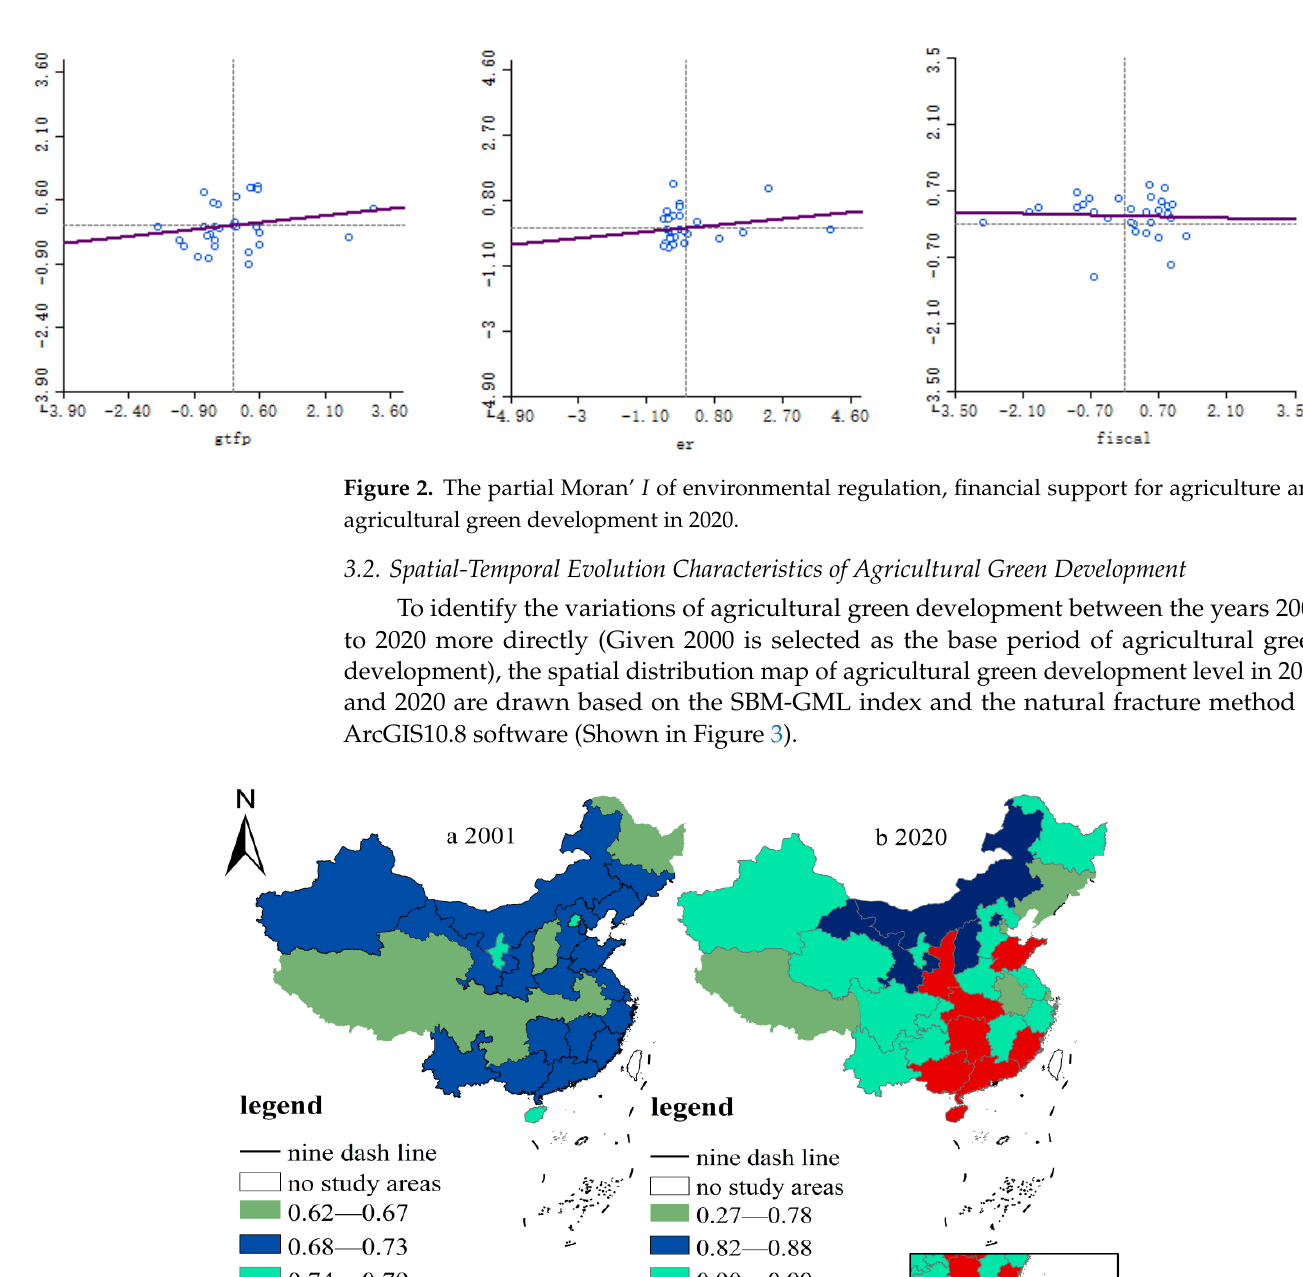
Table 4. The results of spatial Dubin model regression.